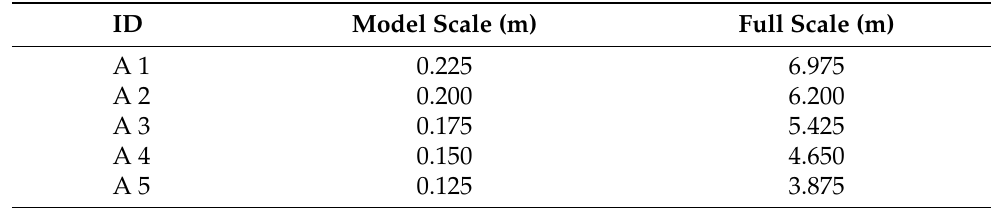
Table 5. Amplitudes of the fairlead motions for λ =